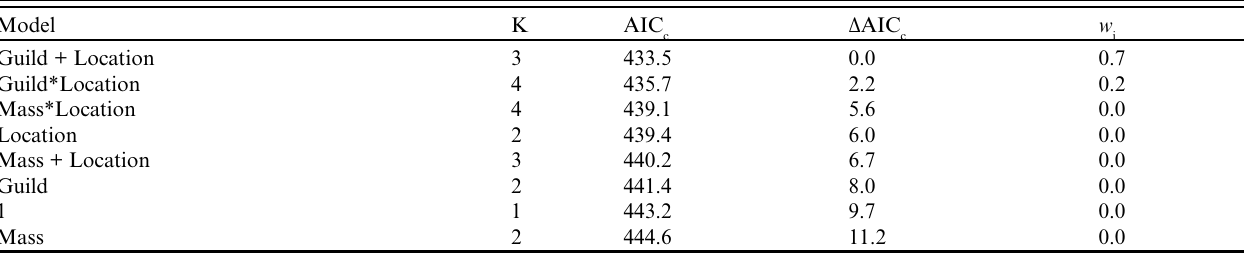
Table 3 . A priori models relating mean foraging flight distances (Mean FFD [km]) to explanatory variables: body mass (Mass [g]), guild (goose or duck), and location (Nearctic and Palearctic). For each model, we displayed the number of parameters (K), Akaike’s Information Criterion corrected for small sample sizes (AIC Model Weight ( w ). i